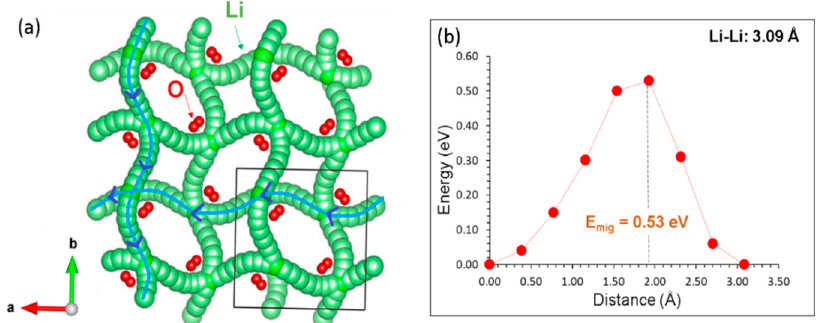
Figure 3. ( a ) Calculated long range three dimensional Li-ion diffusion pathways and ( b ) energy profile diagram for the local Li hop involved in the long range diffusion.